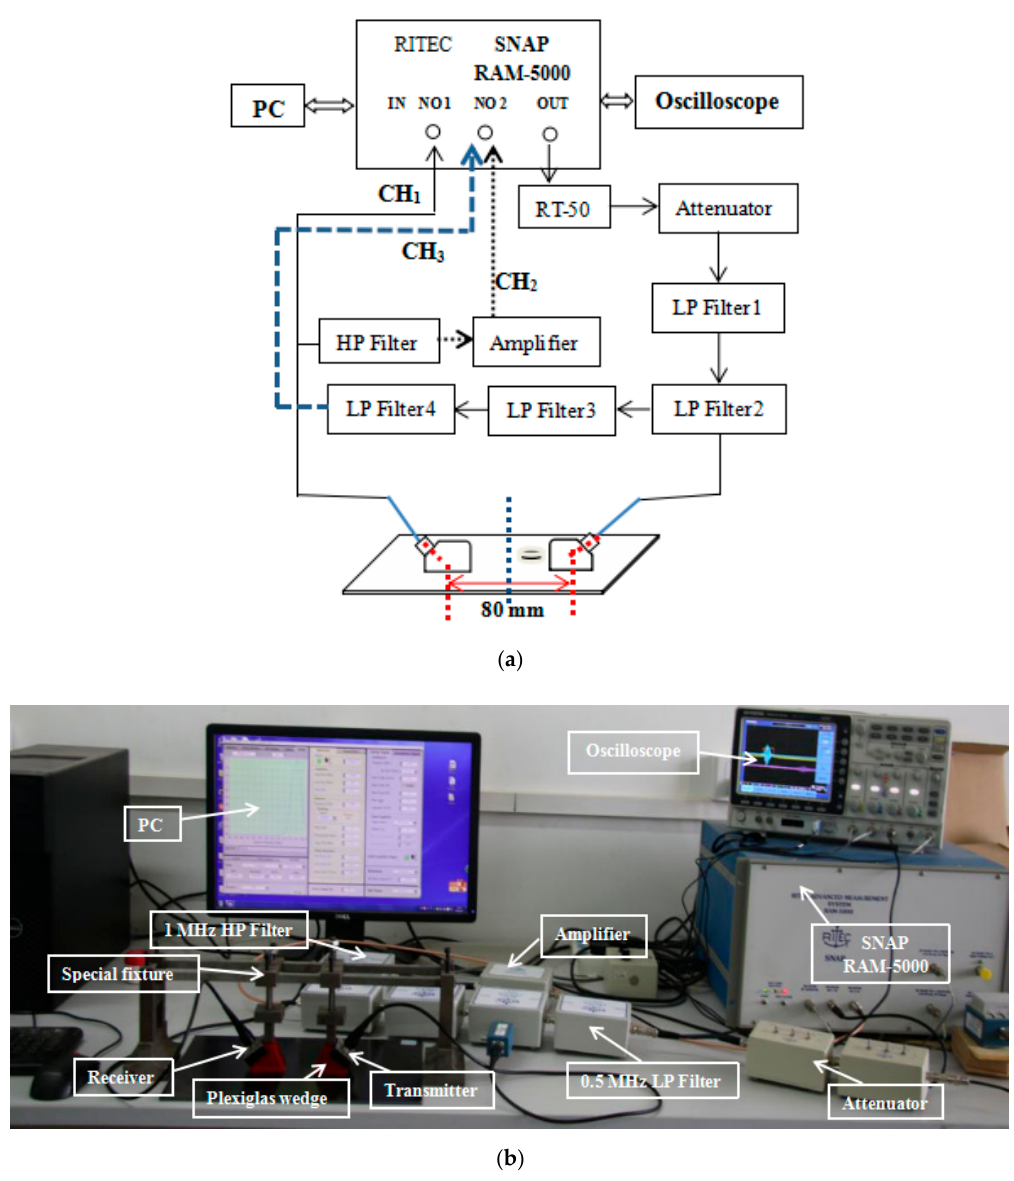
Figure 4. Nonlinear ultrasonic detection system: ( a ) block diagram of the experimental setup and ( b ) photograph of the system.